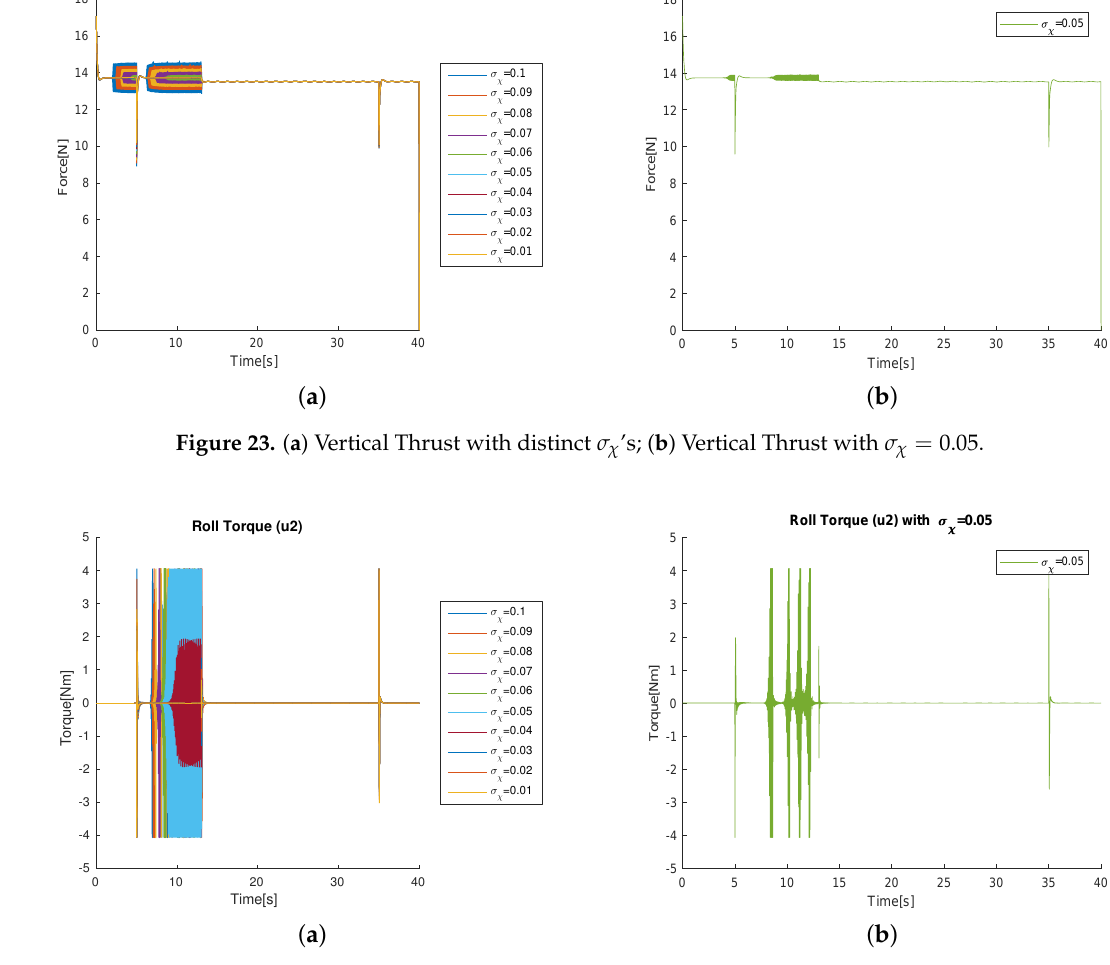
Figure 24. ( a ) Roll Torque with distinct σ χ ’s; ( b ) Roll Torque with σ χ = 0.05.